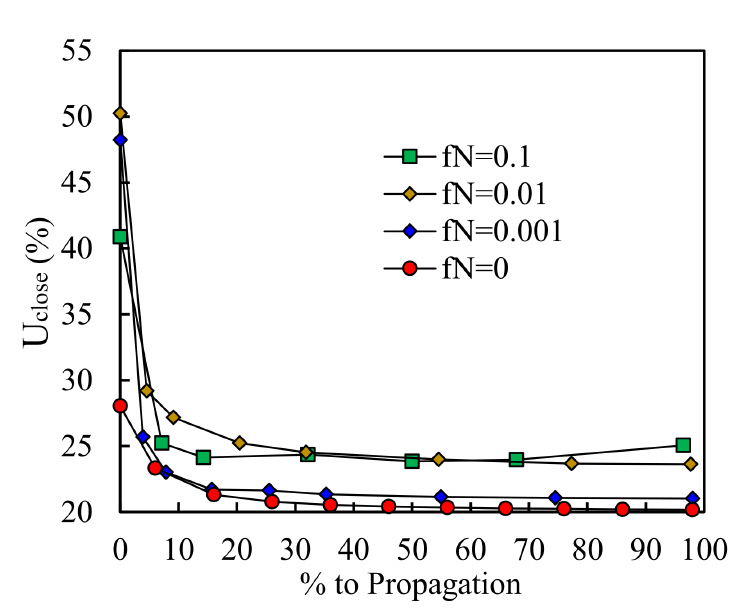
Figure 15. Crack closure through the same propagation studied in Figure 6.